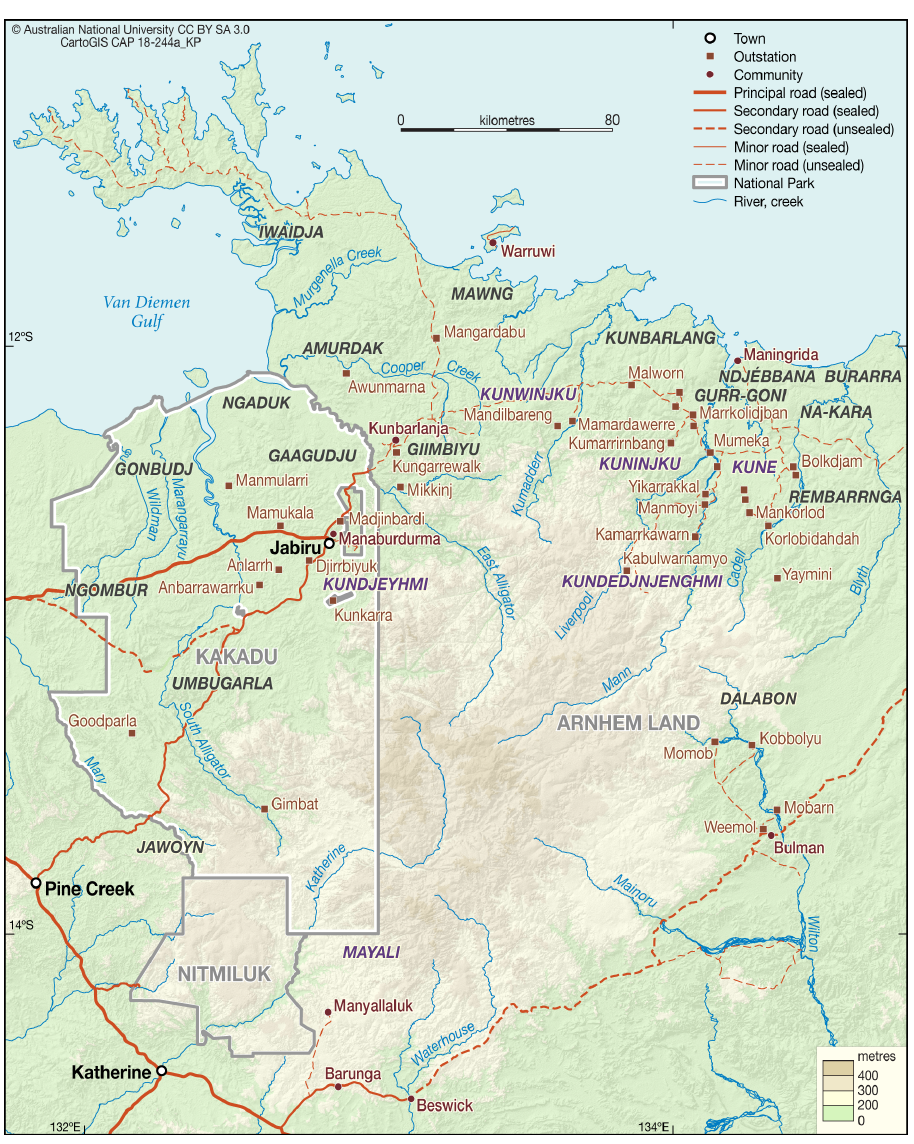
Figure 1. Map of Bininj Kunwok speaking region. Reprinted from Marley (2020, p.